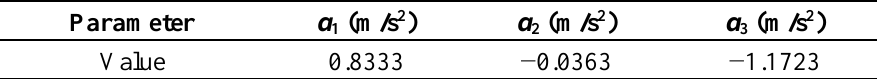
Table 2. The acceleration values of the pilot